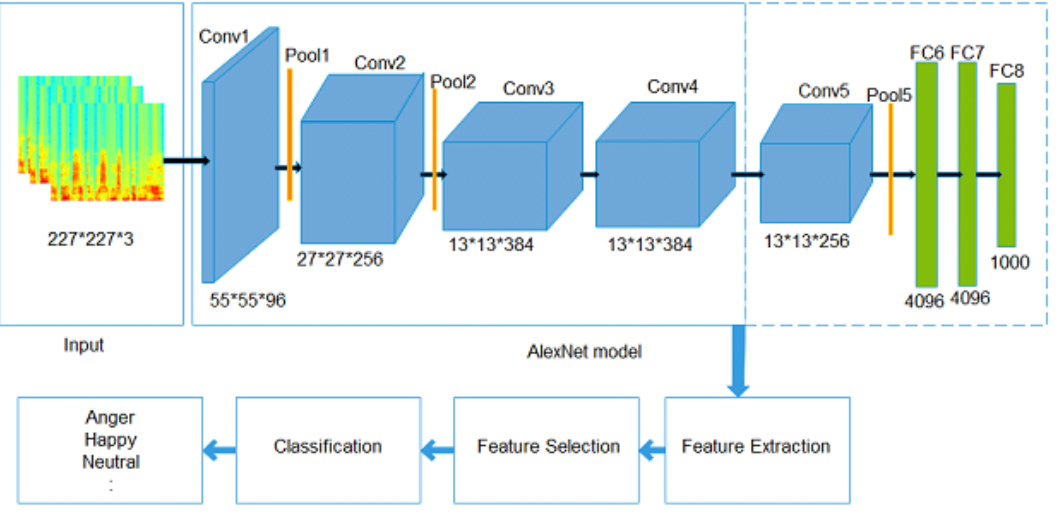
Figure 1. The framework of our proposed